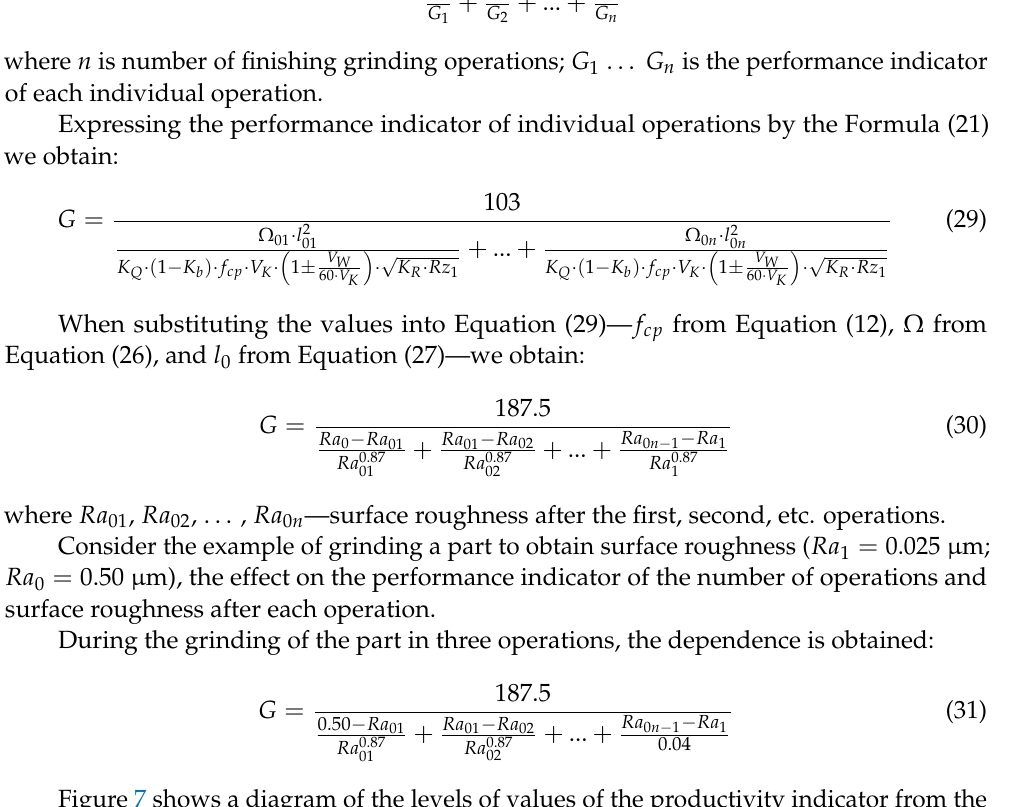
= 𝑐𝑜𝑛𝑠𝑡 ; 2: 𝑙 (cid:2868) = 25.5 ∙ 𝑅 (cid:3028)(cid:2868).(cid:2875)(cid:2870) . V = const ; 2 : l = 25.5 · R 0.72 0 0 0 a